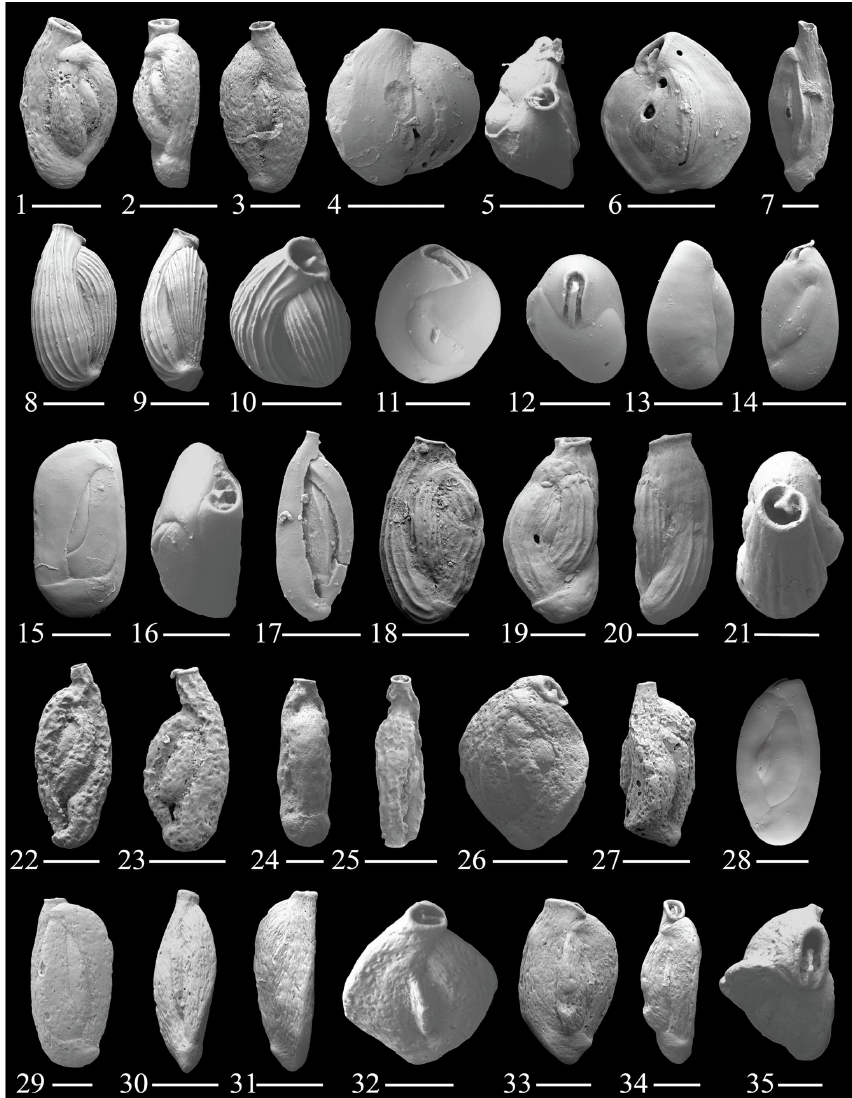
Figure 4. (1–3) Quinqueloculina cf. Q. compta Cushman; (4–6) Quinqueloculina cuvierina (d’Orbigny); (7) Quinqueloculina cf. Q. zhengi Parker; (8–10) Quinqueloculina poeyana d’Orbigny; (11–12) Pseudolachlanella eburnea (d’Orbigny); (13–14) Pseudolachlanella bermudezi (Acosta); (15–16) Quinqueloculina moynensis Collins; (17) Quinqueloculina quinquecarinata Collins; (18–21) Quinqueloculina cf. Q. re- beccae Vella; (22–25) Sigmoilinita costata Schlumberger; (26–27) Quinqueloculina samoensis Cushman; (28) Quinqueloculina tantabid- dyensis Parker; (29) Quinqueloculina sp. 2; (30–32) Quinqueloculina sp. 1; (33–35) Quinqueloculina sp. 4. The scale bar is 100 and 50µm for figs. (11) – (12) , (16) , (21) , (24) , (26) , (29) , (30) – (31) , and (33)